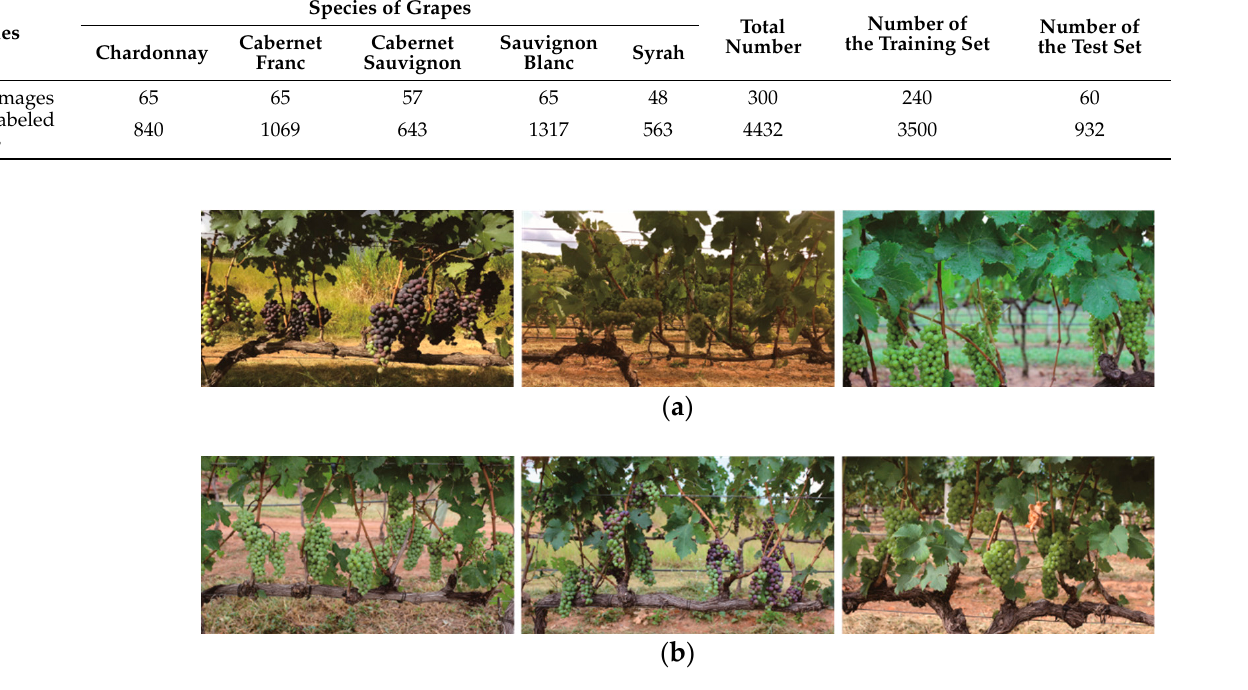
Figure 1. Grapes under different light, color, and overlapping scenes. ( a ) Grapes under sunny, cloudy, and rainy. ( b ) Green grapes, purple grapes, and overlapping grapes. Table 2. The detailed information about the wGrapeUNIPD-DL.